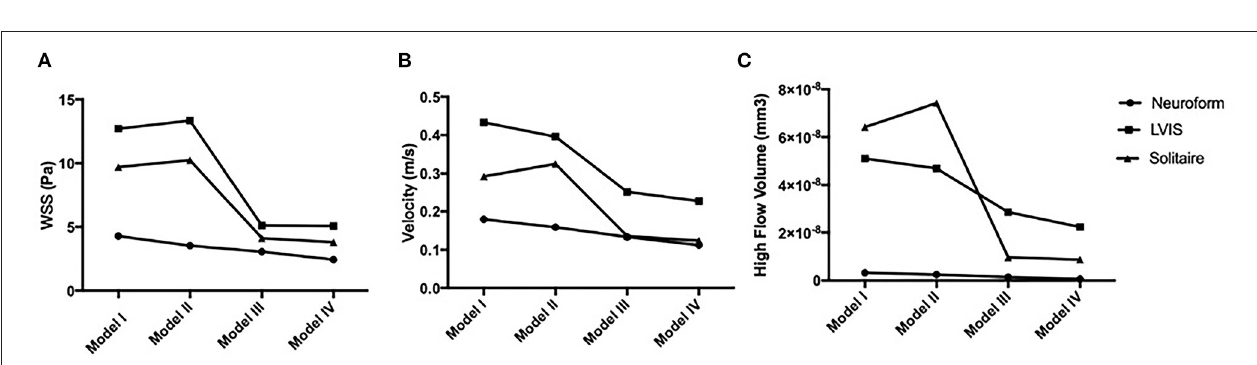
FIGURE 7 | Hemodynamic characteristics tendencies for the four models in three stents are analyzed. (A) Wall shear stress (WSS); (B) velocity (m/s); (C) high flow volume